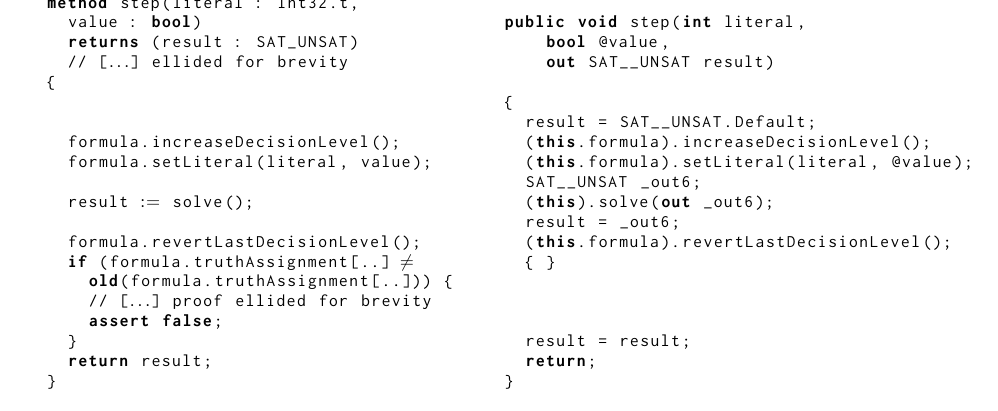
Figure 6. Example of how Dafny compiles the code to C#. Aside from the minor and mostly cosmetic changes, note that proofs are not copied over. We add the spacing ourselves to improve